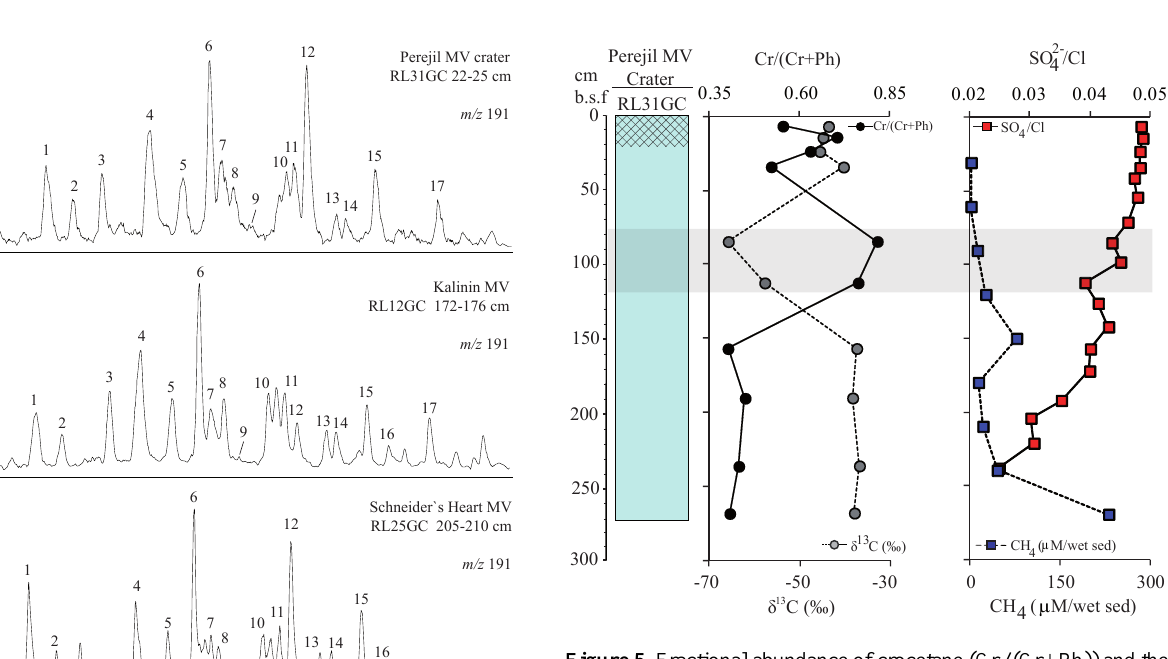
Figure 5. Fractional abundance of crocetane (Cr/(Cr + Ph)) and the stable carbon isotope composition of the phytane/crocetane peak vs. depth in mud breccia of the Perejil MV crater. Concentrations of methane and SO 2 − /Cl ratio from gases and pore fluids showing 4 the zone of anaerobic oxidation of methane